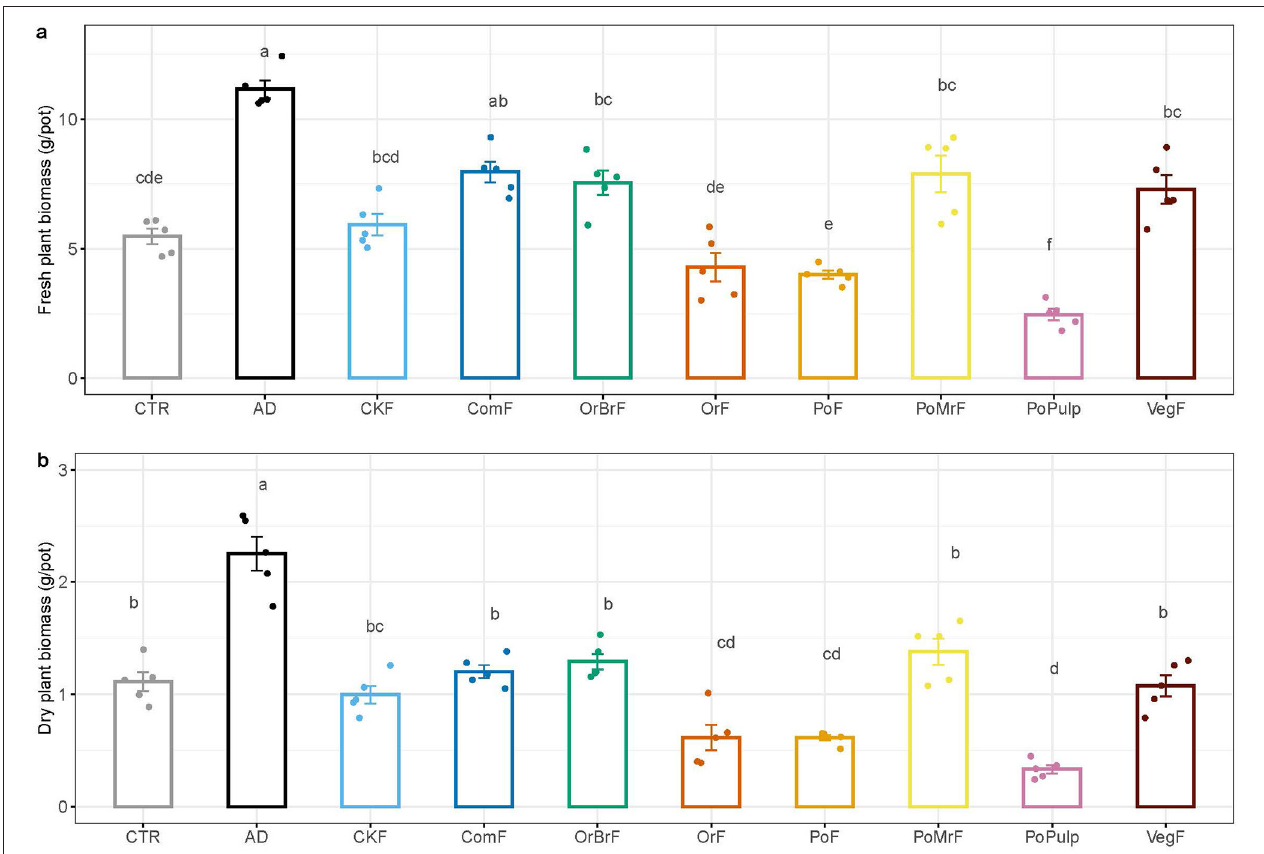
FIGURE 6 | Mean values of aboveground fresh (A) and dry biomass (B) (mg/pot) of the maize plants at the end of the plant growth pot experiment ( n = 5 ± SE). Note the differences in the y-axis